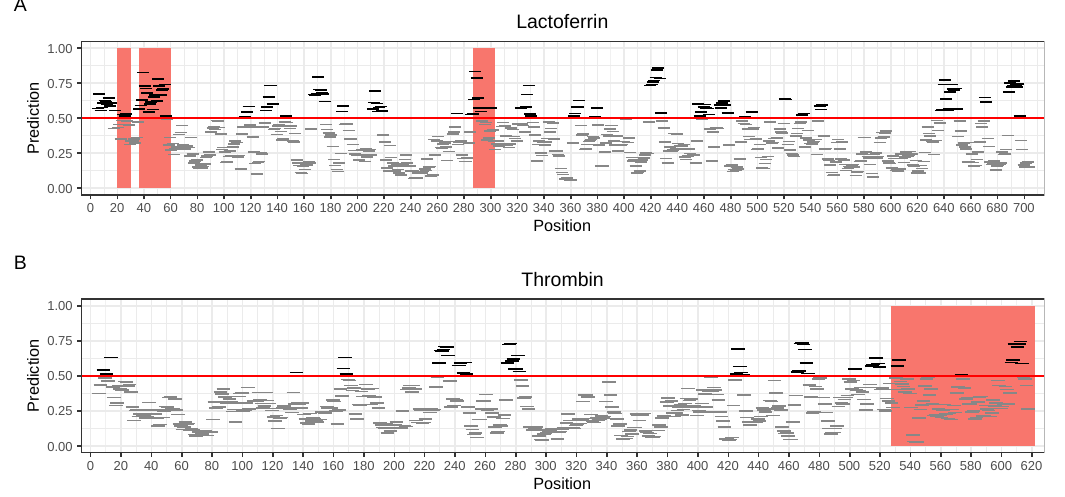
Figure 3. Distribution of 10-mers along the lactoferrin ( A ) and thrombin ( B ) sequences. AMP and non-AMP 10-mers were indicated by black and gray horizontal lines, respectively. The red line represents the cut-off value of 0.5. The red bars mark the fragments that have already been experimentally verified as AMPs: 1–11, 17–41 and 268–284 for lactoferrin [32] and 527–622, 597–622 and 604–622 for thrombin [37]; the sequence coordinates for lactoferrin do not include an N-terminal signal peptide